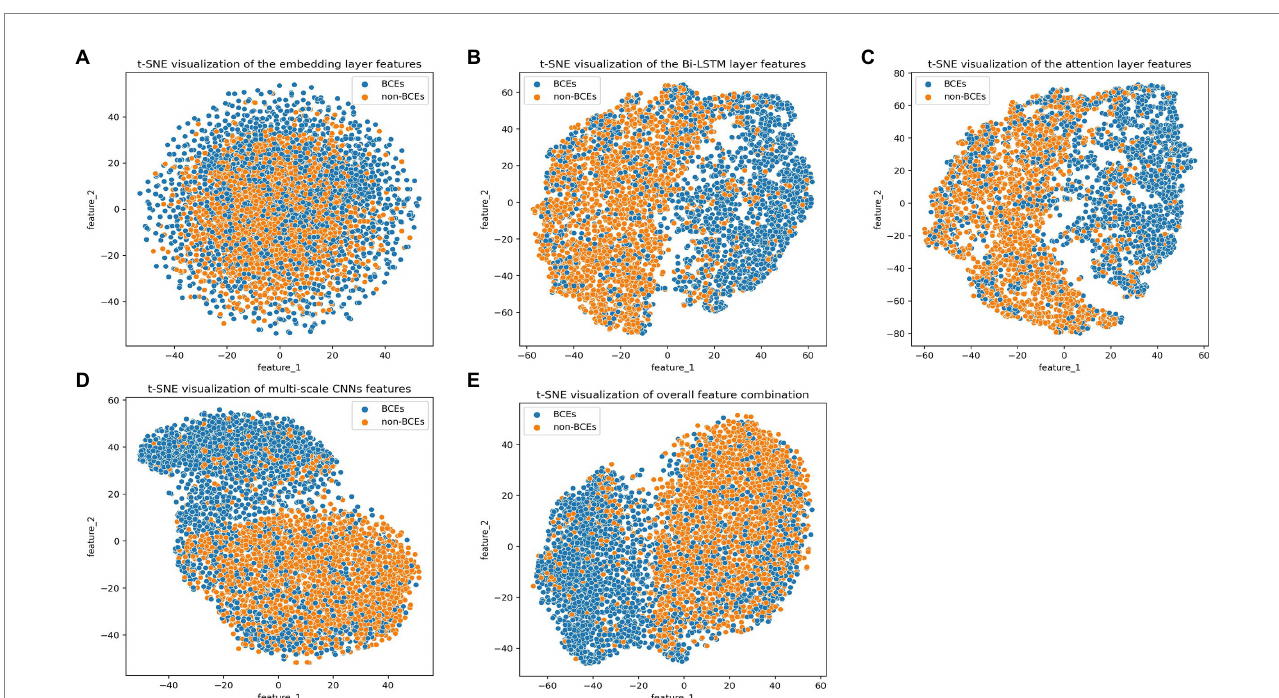
FIGURE 2 t-SNE visualization of outputs of (A) the embedding layer, (B) the Bi-LSTM layer, (C) the attention layer, (D) the multi-scale CNNs, and (E) overall combination.